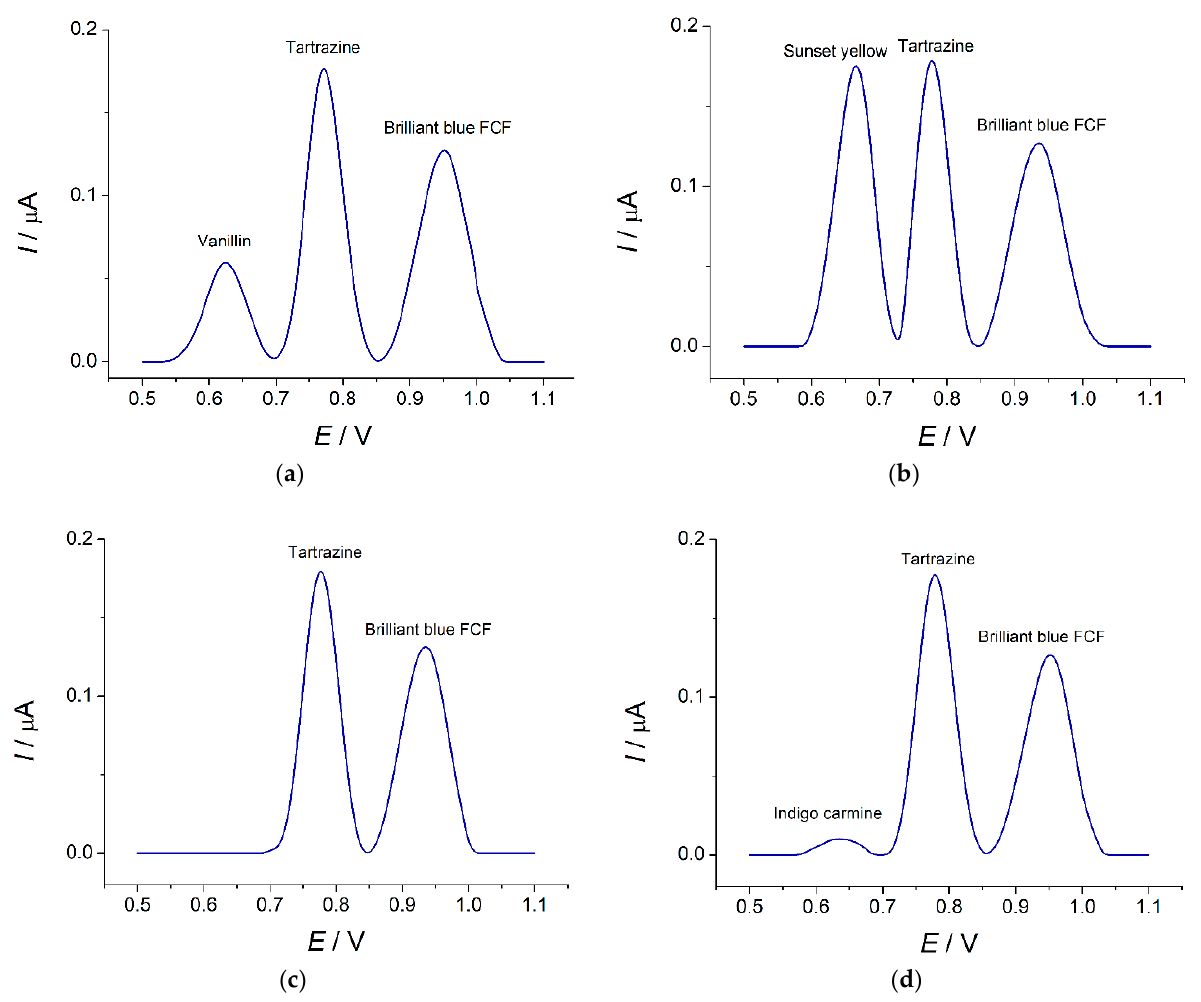
Figure 10. Baseline-corrected differential pulse voltammograms of ternary mixtures on the MnO 2 nanorods-based sensor in phosphate buffer pH 7.0: ( a ) 0.75 μM vanillin, tartrazine, and brilliant blue FCF; ( b ) 0.75 μM sunset yellow, tartrazine, and brilliant blue FCF; ( c ) 37.5 μM riboflavin, 0.75 μM tartrazine and brilliant blue FCF; ( d ) 7.5 μM indigo carmine, 0.75 μM tartrazine and brilliant blue FCF. Pulse amplitude = 75 mV, pulse time = 25 ms, υ = 20 mV s ‒1 .